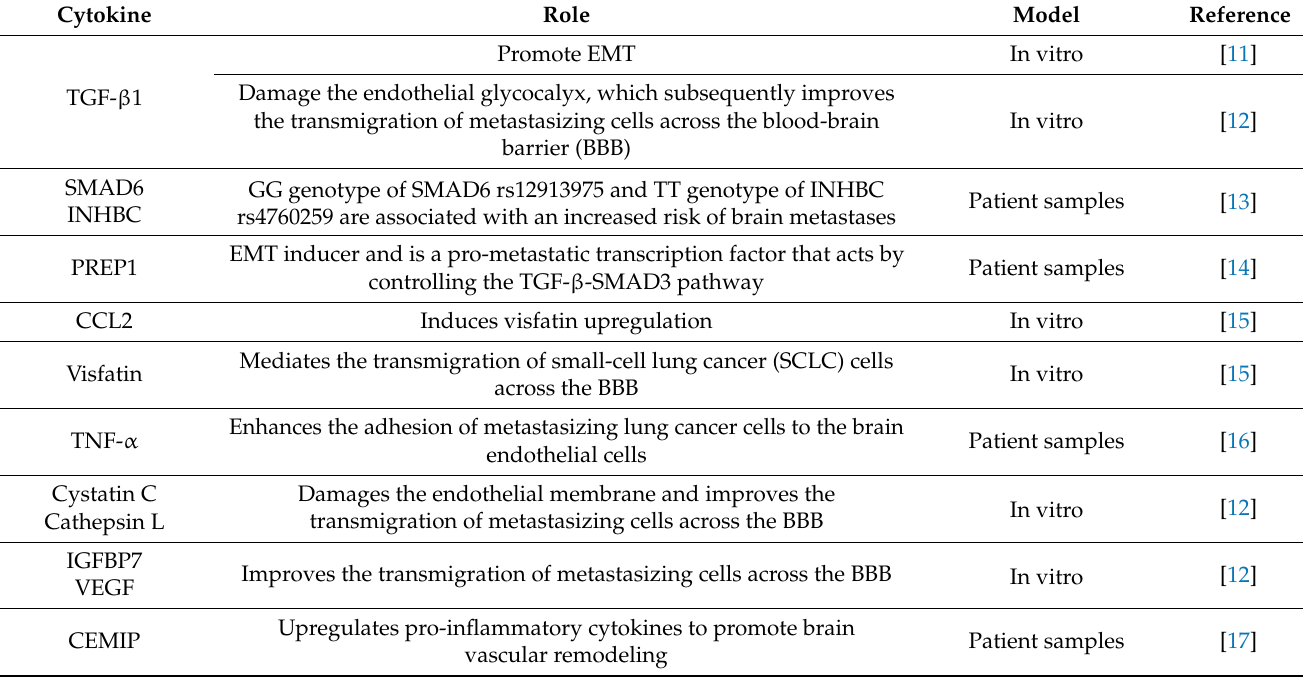
Table 1. Cytokines reported to have a role in lung cancer brain